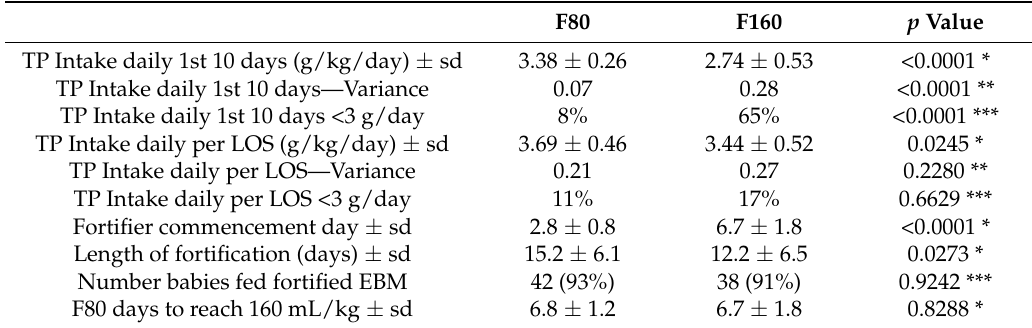
Table 3. Nutrition and feeding